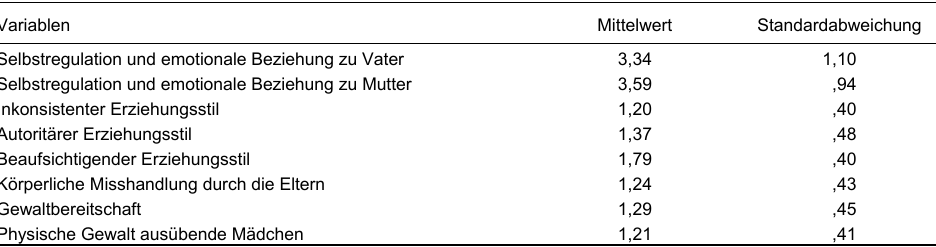
Tabelle 1 : Kennwerte der eingeführten Variablen Variablen